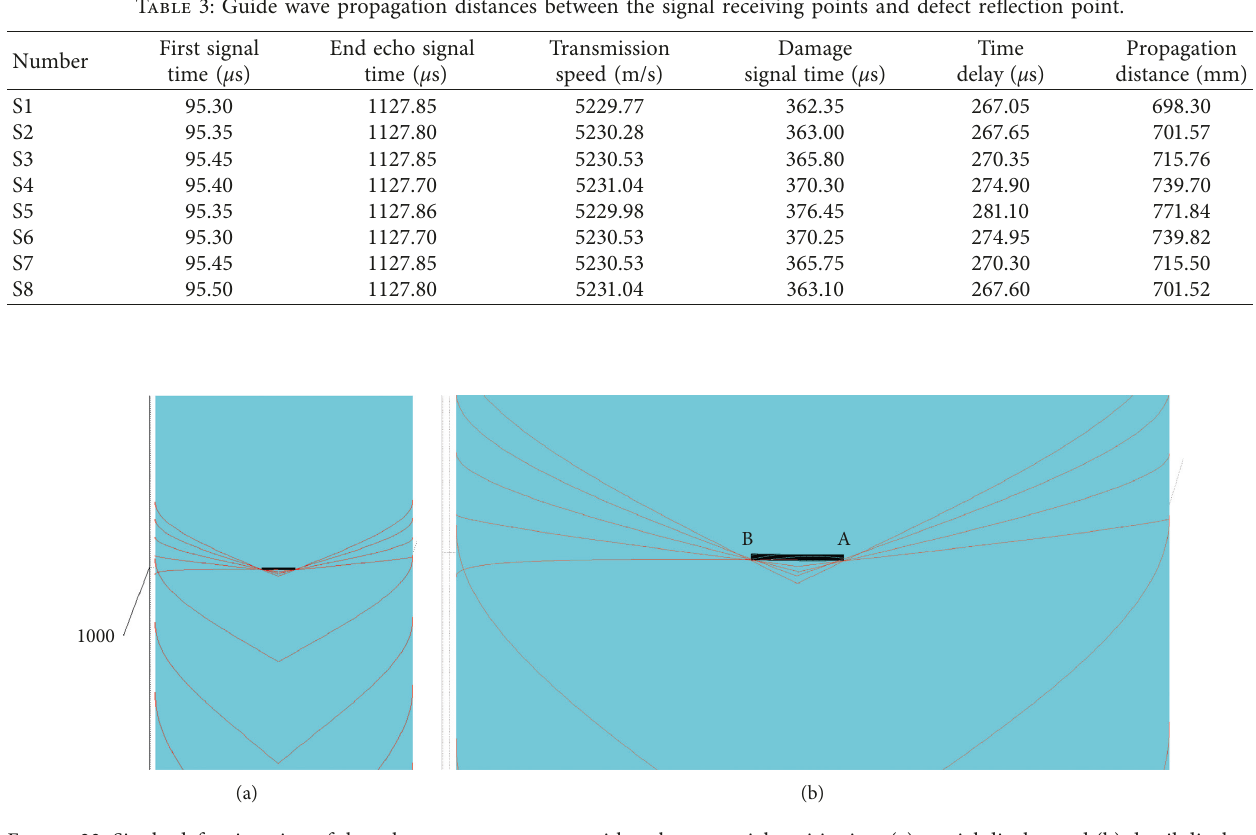
Figure 23: Single-defect imaging of the tube segment structure with unknown axial positioning: (a) partial display and (b) detail display.